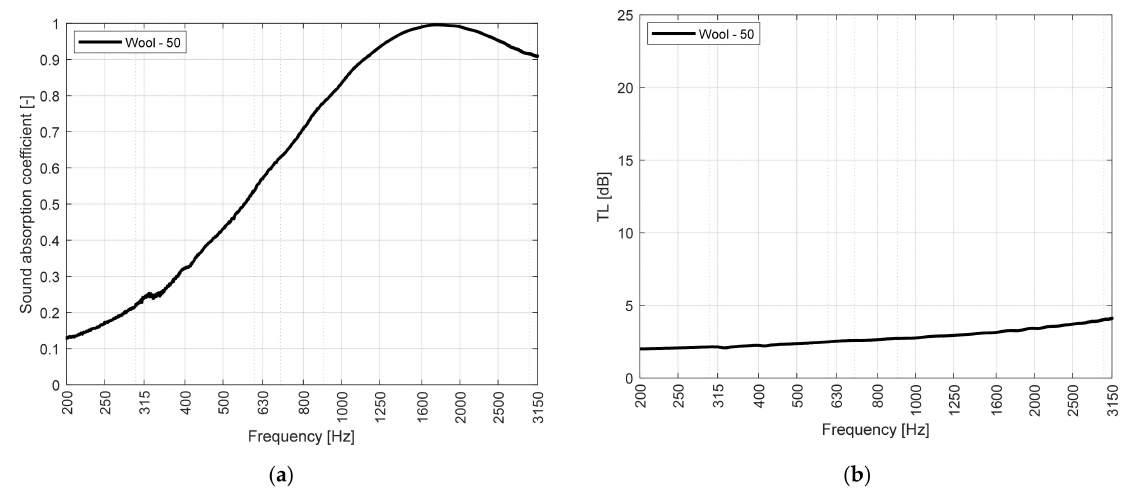
Figure 8. Acoustic properties of white dross wool sample: ( a ) sound absorption coefficient; and ( b ) transmission loss.